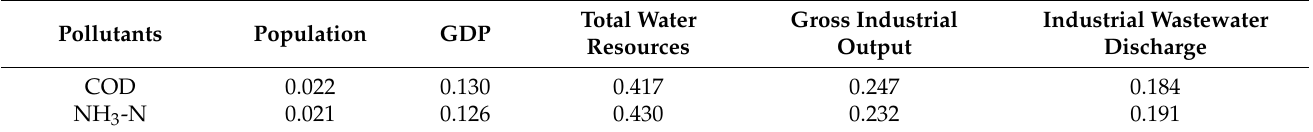
Table 3. Information entropy weight of each evaluation index in fairness